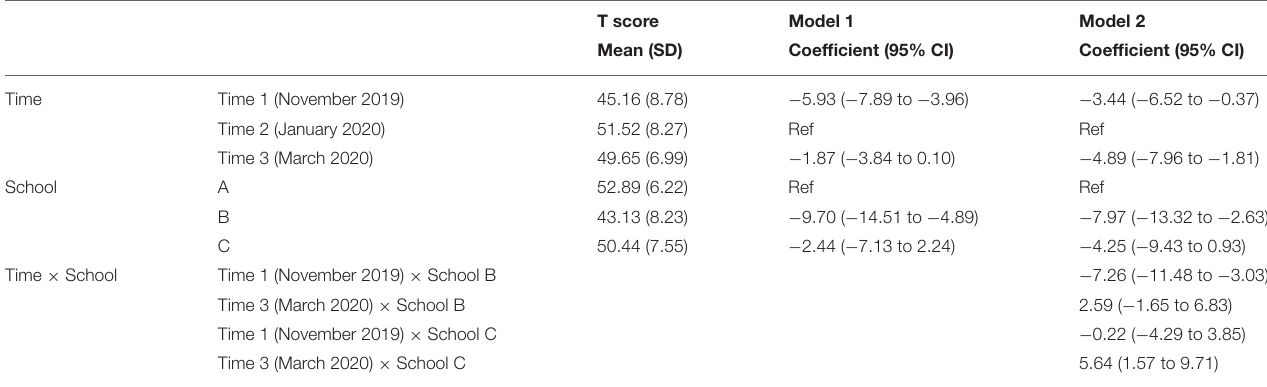
TABLE 2 | Results of repeated measures mixed model ( n =